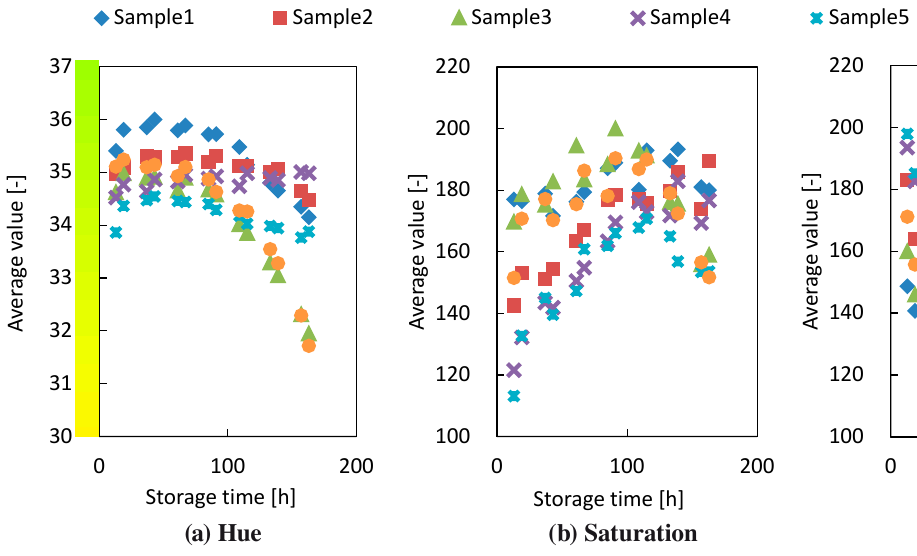
Fig. 12: Color change of lettuce leaves FFiigg.. 1122 CCoolloorr cchhaannggee ooff lleettttuuccee lleeaavveess 705